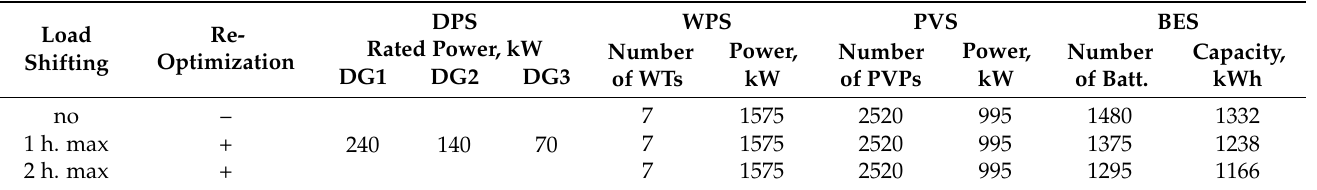
Table 11. Optimal parameters of D/W/PV+B configuration with and without electric load shifting. Load